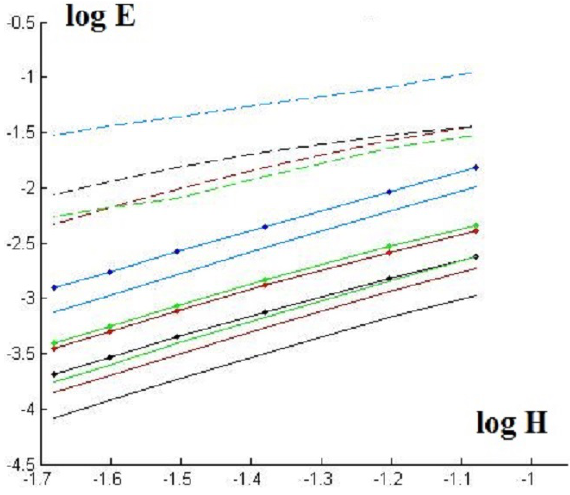
Figure 10. Logarithm of the relative error (log E ) via logarithm of the grid step (log H ); 3-D case, exponentially varying viscosity, high-viscosity contrast ( η 2 = η 3 = η 4 = 100); blue lines – pressure, red lines – v x , black lines – v y , green lines – v z ; solid lines – L 1 - error, dashed lines – L ∞ -error, solid dotted lines – L 2